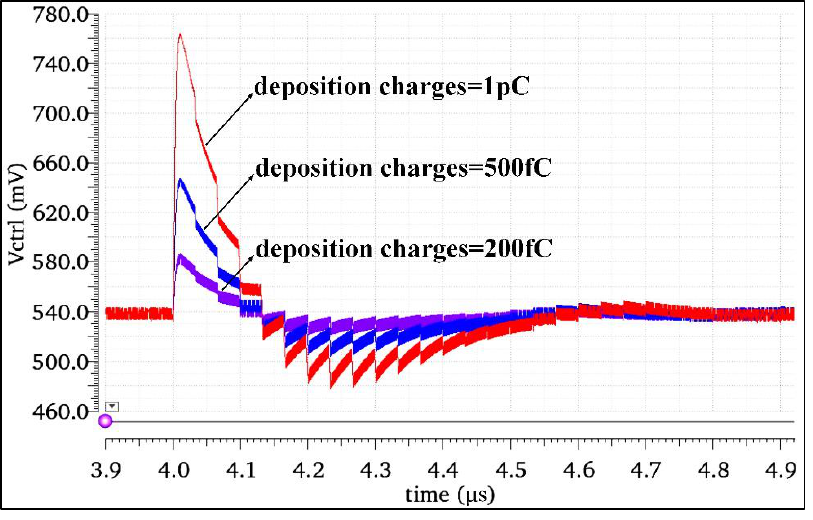
Figure 6. Simulation results of the response to the SET with different bombardment energies in the charge pump.